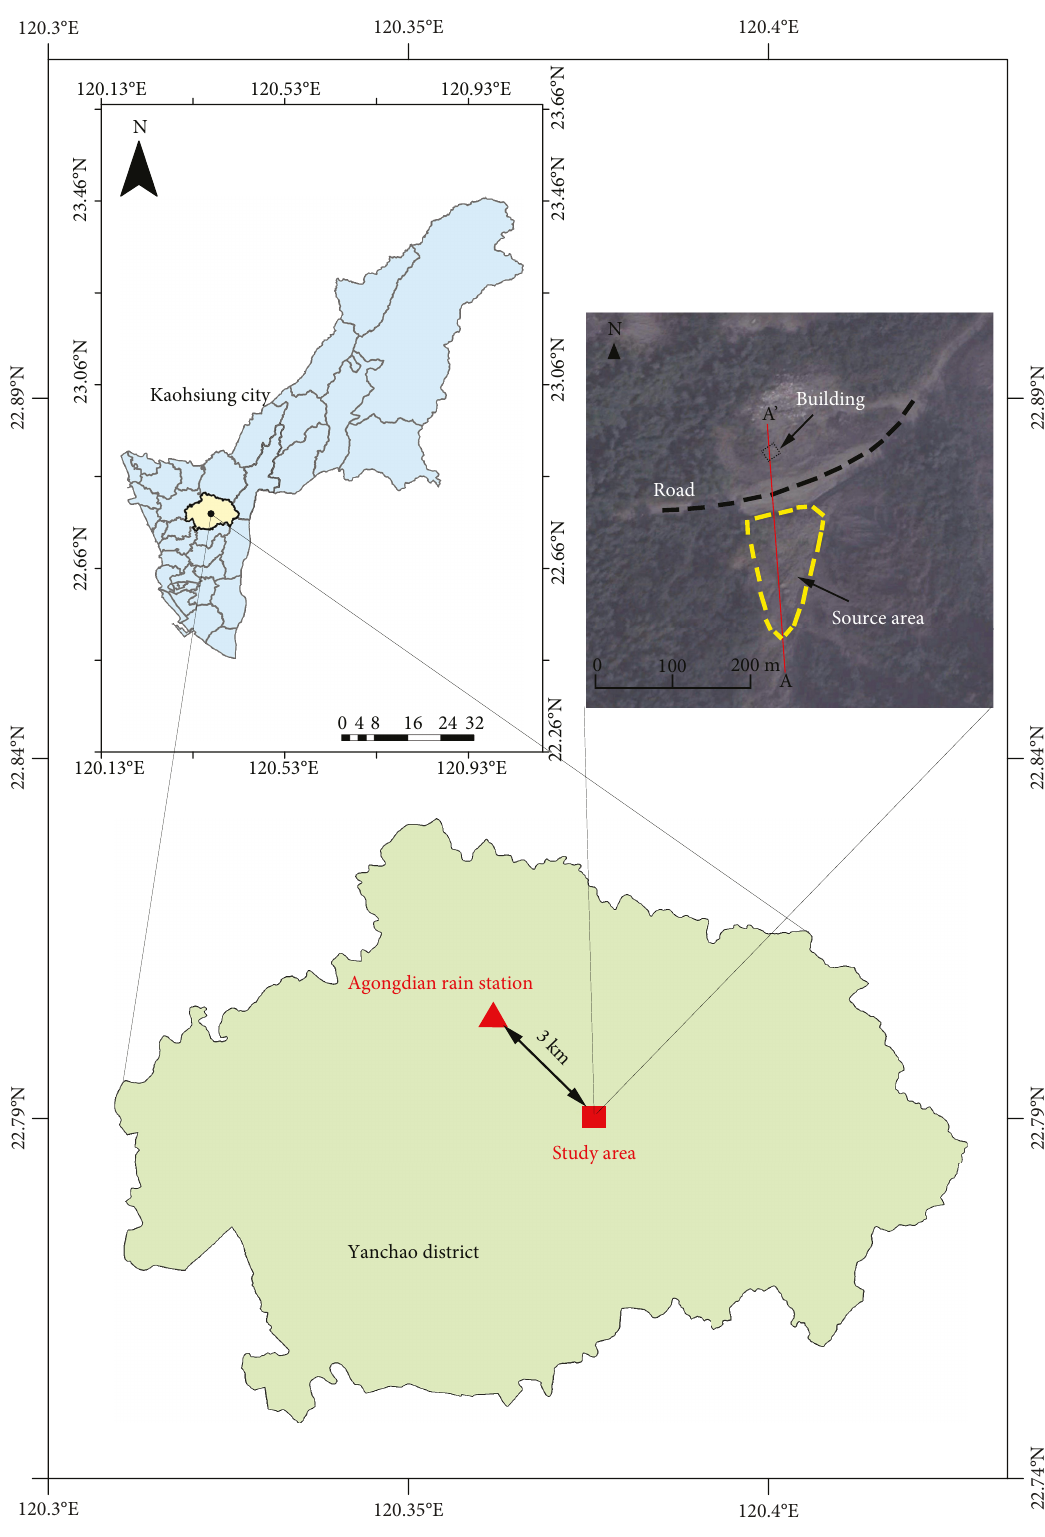
Figure 1: Location of the study area and the Agongdian rain